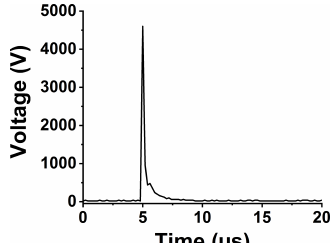
Figure 2. Spark voltage evolution in